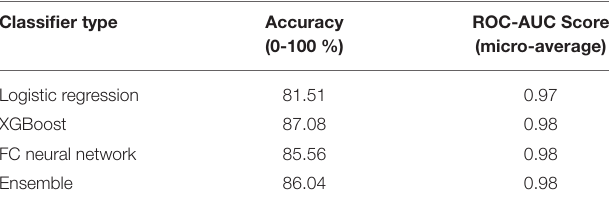
TABLE 2 | Comparison of three individual classifiers (multiclass logistic regression, XGBoost, and fully connected neural network) and of the classification ensemble based on two performance metrics (accuracy and ROC-AUC